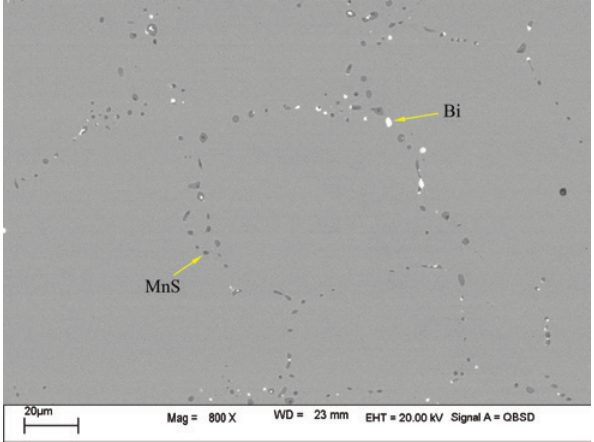
Fig. 2: Existing form of bismuth in the steel from solubility